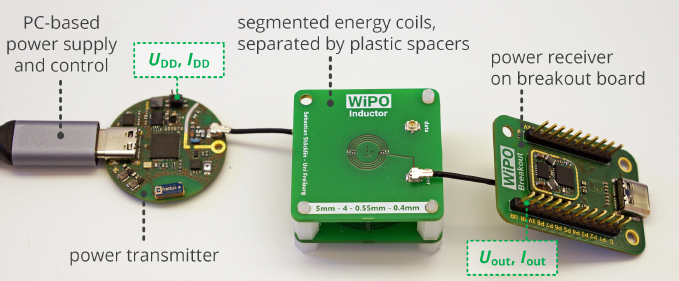
Figure 11. Measurement setup for the experimental analysis, including the analog test points for voltage and current measurement.